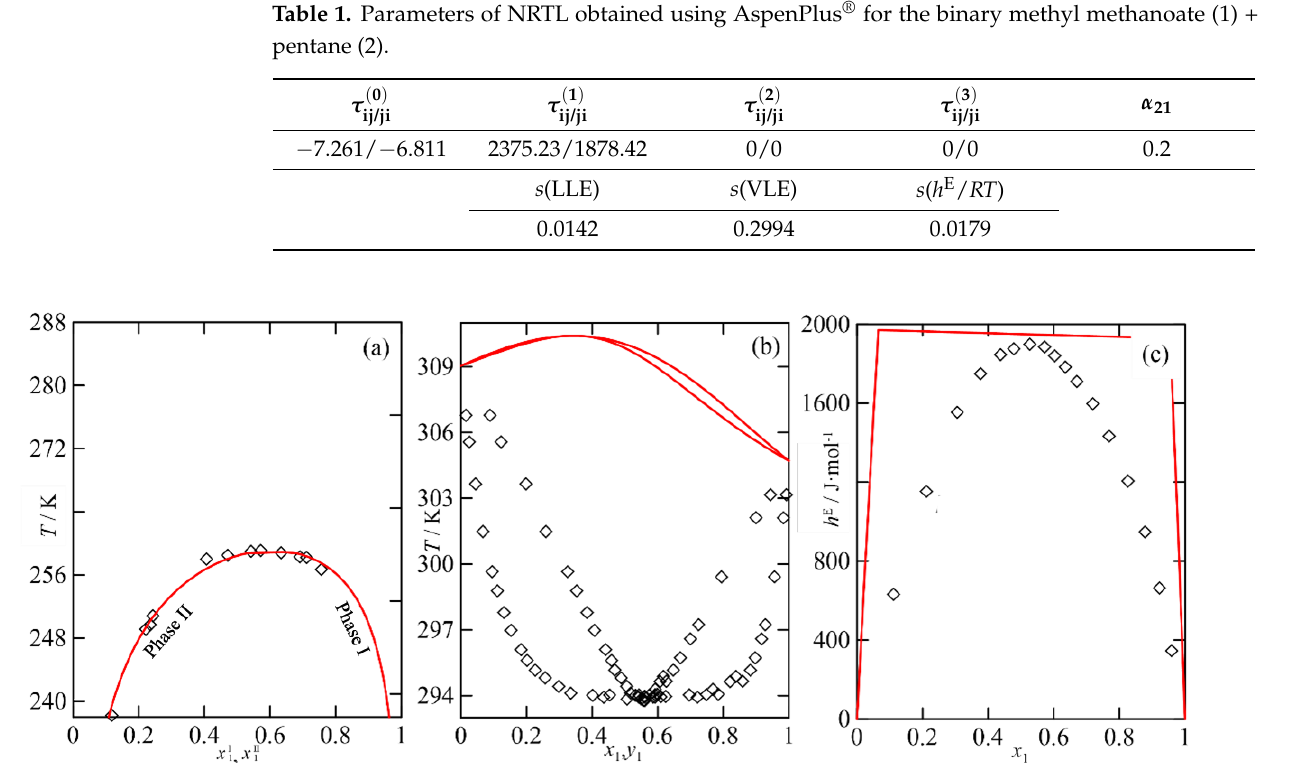
, o r T v s xx ; ( b ) , or x II ; ( b ) VLE, 11 1 1